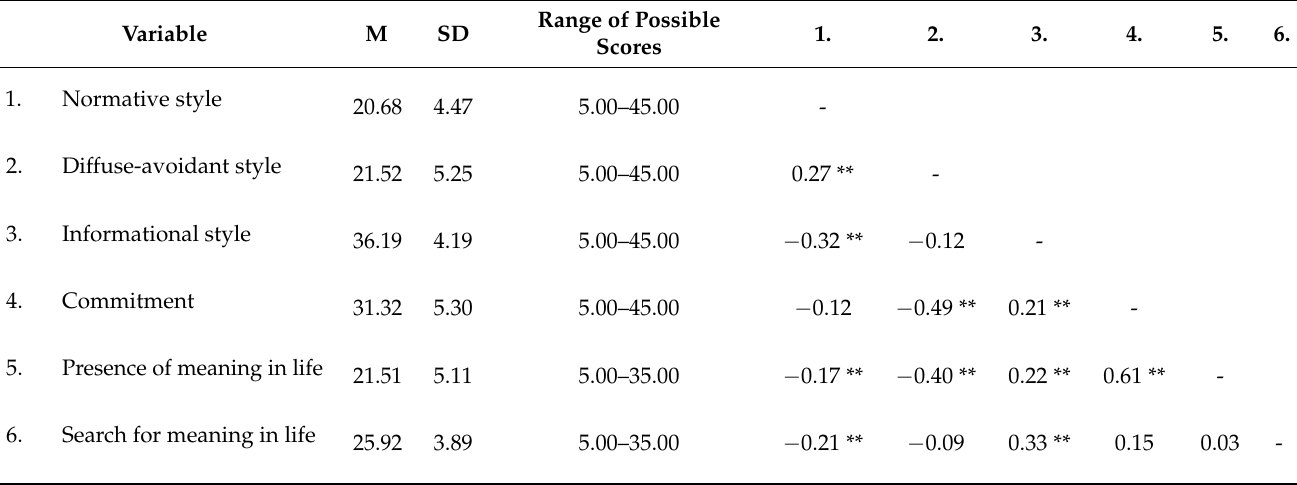
Table 1. Means, standard deviations and correlations among all study variables.